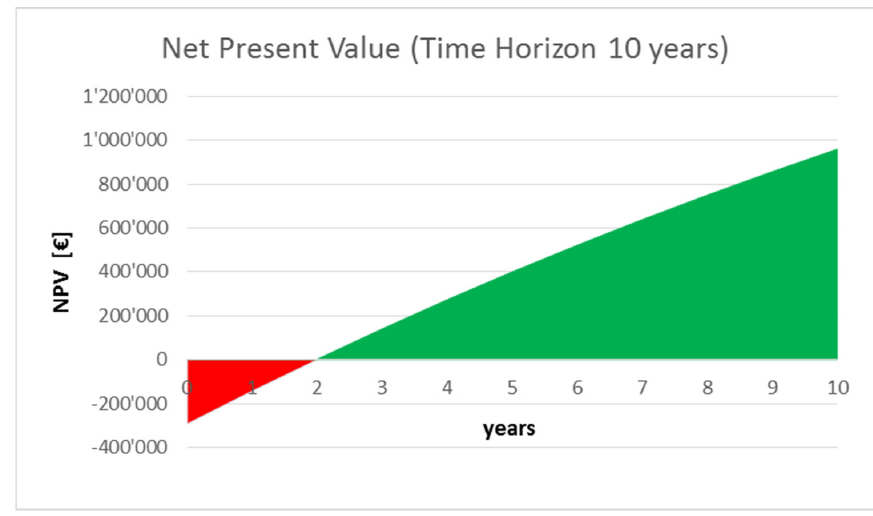
Figure 17. NPV evolution in the time horizon of 10 years. The positive return is underlined by the green colour.